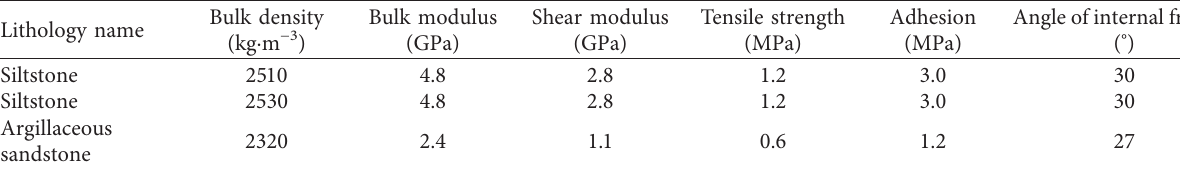
Table 3: Physical-mechanical parameters of